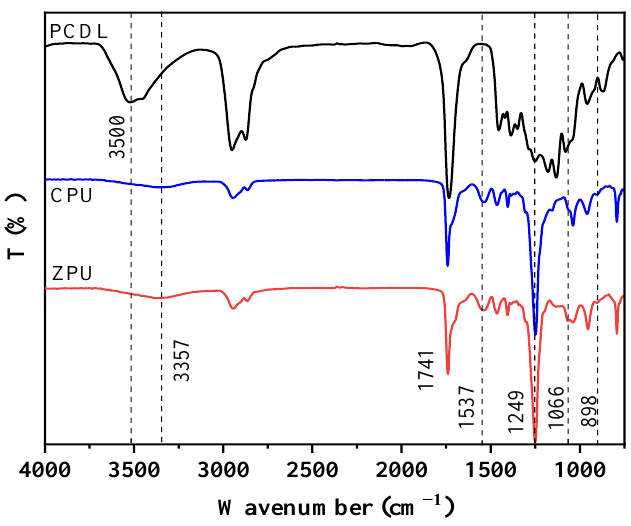
Figure 2. FTIR of ZPU and CPU.